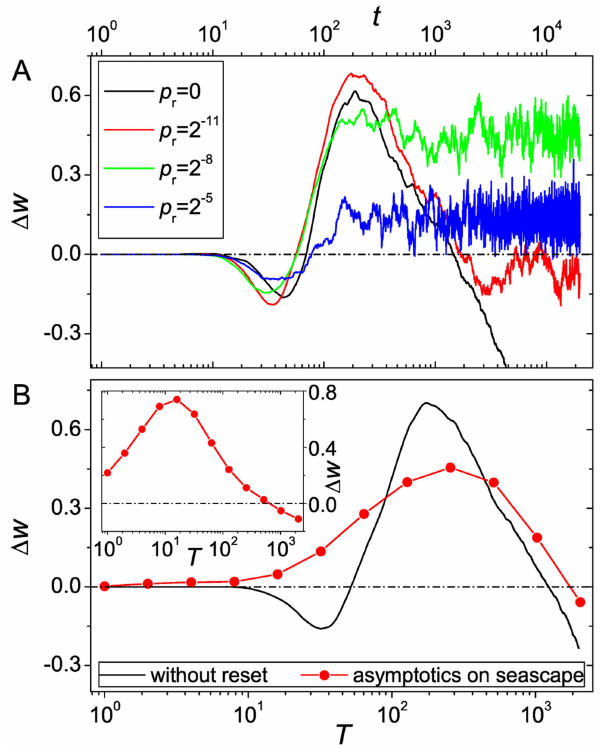
Figure 9. Advantage of recombination in fitness seascapes. (A) Time series of the fitness advantage D w of a seascape with hard reset. (B) Asymptotic fitness advantage D w in dependence on T ~ 1 = p r in the stationary state of the seascape with hard reset. The data are extracted from the time series and correspond to the value of D w averaged over generations 5000 to 20000. For comparison we also plotted the time series for the same set of parameters on the corresponding (static) landscape and a random initial genotype. The parameters are c ~ 0 : 75 , N ~ 2000 and m ~ 0 : 0025 . In the inset we show the stationary advantage on a seascape with soft reset.